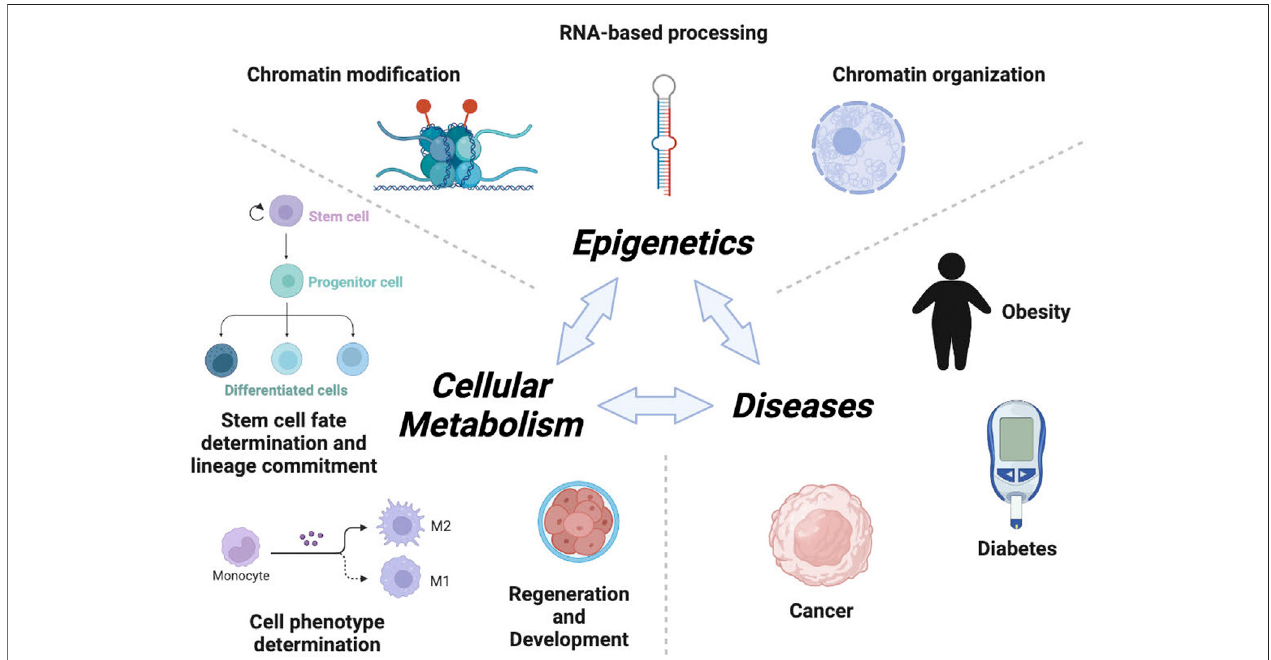
FIGURE 1 | Metabolism and Epigenetics co-ordinate the development and disease. Cellular metabolism, the basic physiological unit of an organism, is subject to epigenetic regulation. Key cellular decisions such as self-renewal, stem cell fate determination, lineage commitment, and functional speci fi cation are determined by epigenetic regulation. Metabolites fuel the epigenetic machine in the form of substrates or co-factors for chromatin remodeling enzymes. Impaired epigenetic regulatory mechanisms (chromatin modi fi cation, organization and RNA-based processing, etc) in cellular metabolism may shift the physiological equilibrium into an imbalanced state, potentially contributing to disease (e.g. obesity, cancer, diabetes,